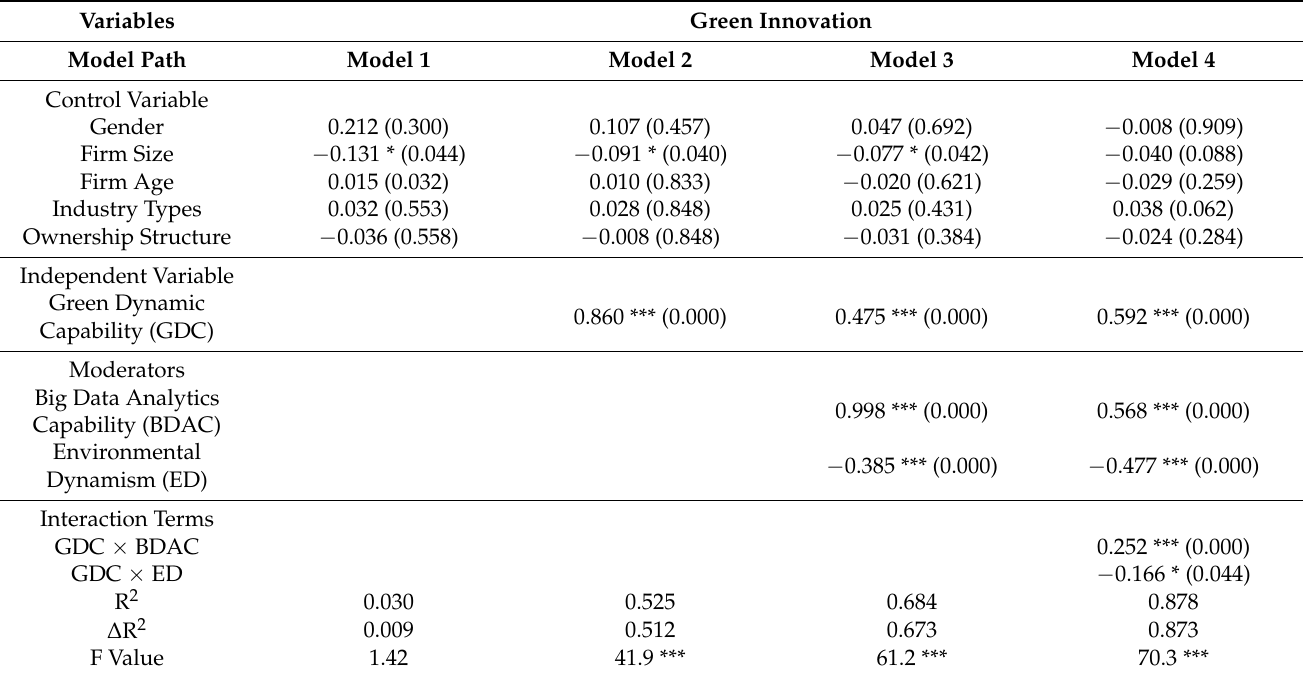
Table 6. Pakistani SMEs Hierarchical Regression Analysis Results.